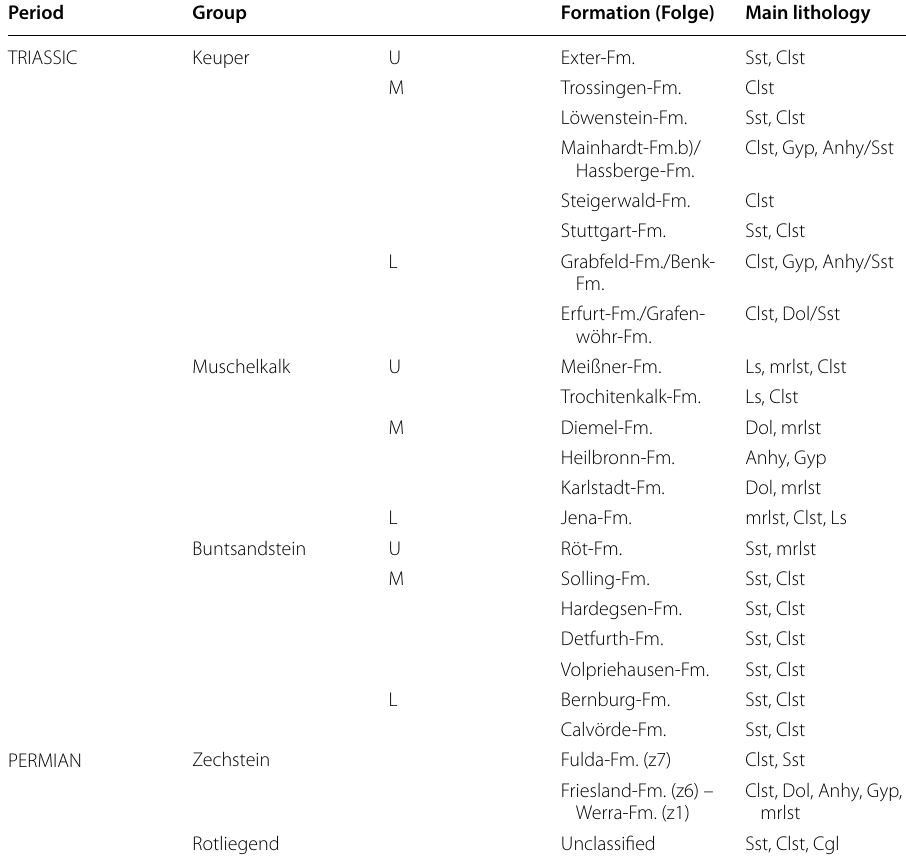
Table 1 Stratigraphic chart and main lithologies of the Permo-Triassic sedimentary succession in SE Germany (STC